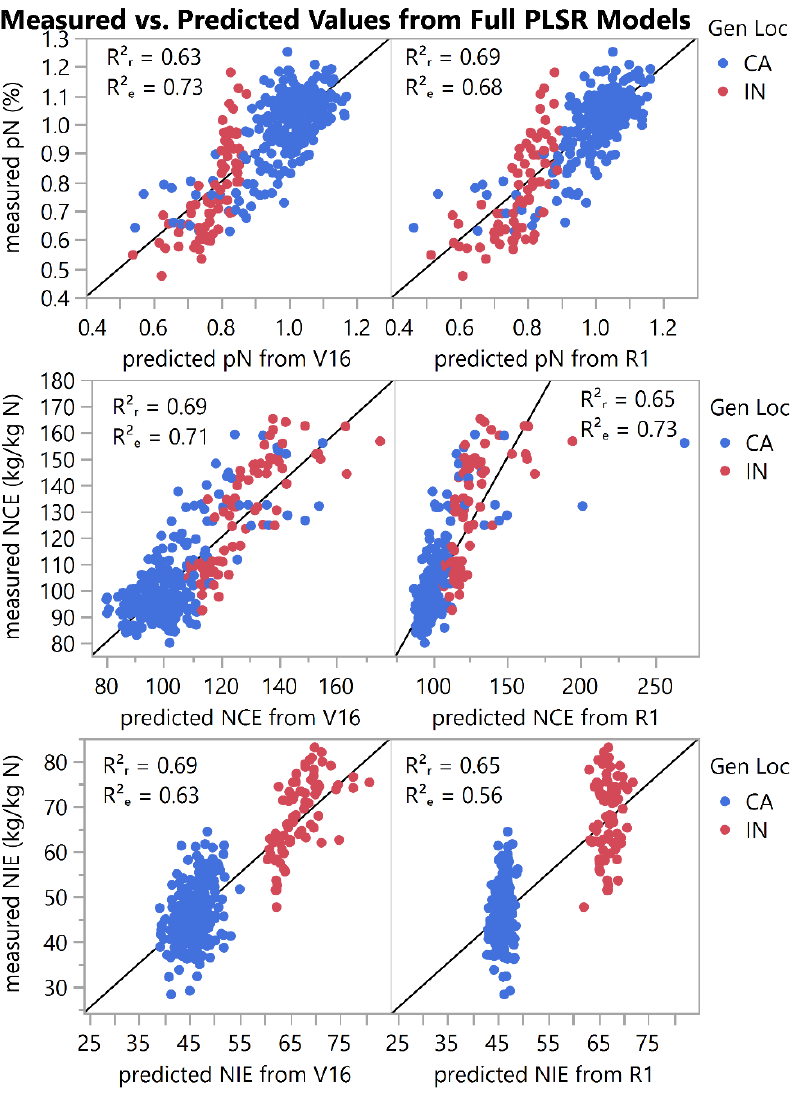
Figure 6. Measured by predicted plots for full PLSR models based on spectral data at V16/18 or R1/R2 for training and test data sets. R 2 r = R 2 for training data set; R 2 e = R 2 for test data set; pN = nitrogen concentration (%); NCE = nitrogen conversion efficiency (kg/kg N); NIE = nitrogen internal efficiency (kg/kg N); Gen Loc = general location; CA = California, blue dots (Gorman and Rominger locations); IN = Indiana, red dots (ACRE location). Black line is 1:1 reference line.